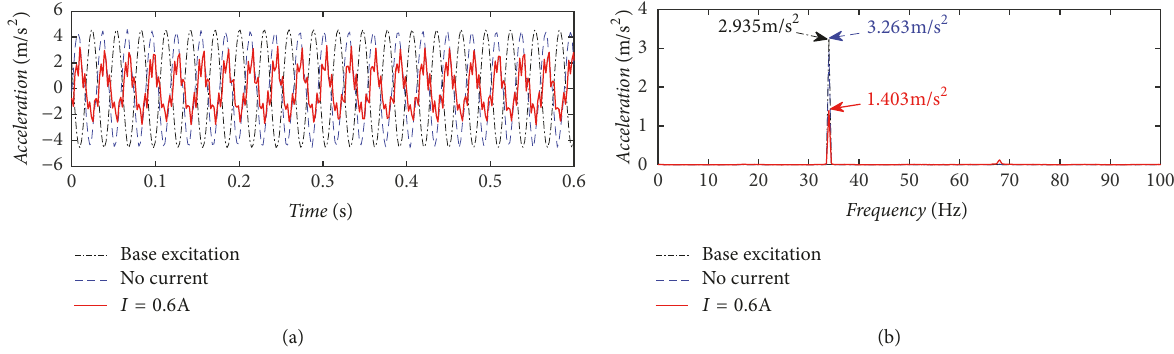
Figure 13: Isolation performance of the isolator for a base excitation frequency of 34Hz: (a) time domain and (b) frequency domain.